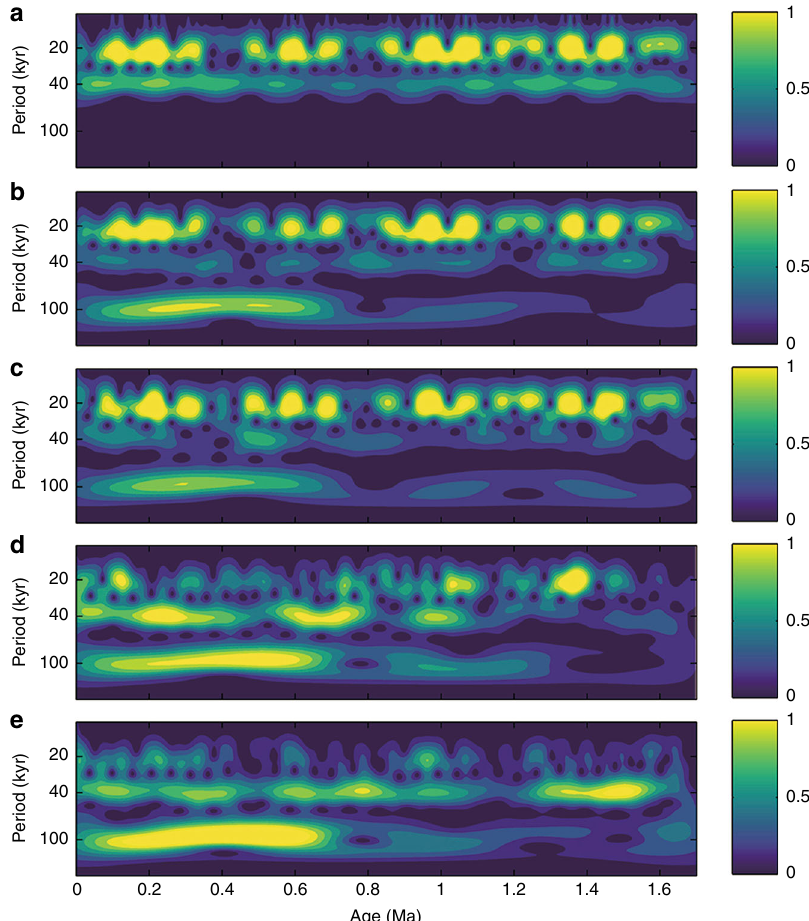
Fig. 7 Wavelet power spectra. a Summer insolation 55 , b simulated MAP, c simulated mean annual temperature, d loess δ 13 C IC , and e benthic δ 18 O stack